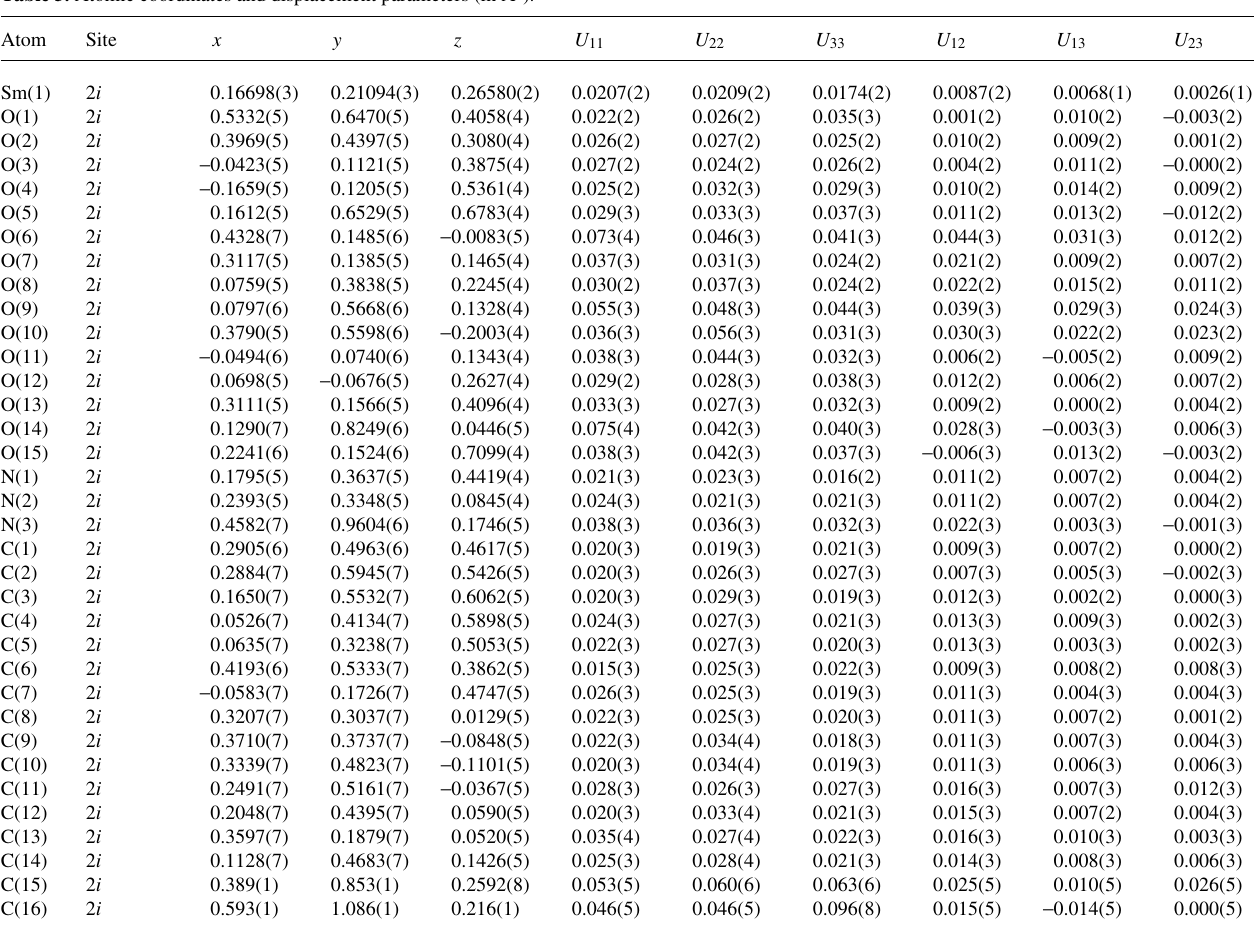
Table 3. Atomic coordinates and displacement parameters (in Å 2 ) .